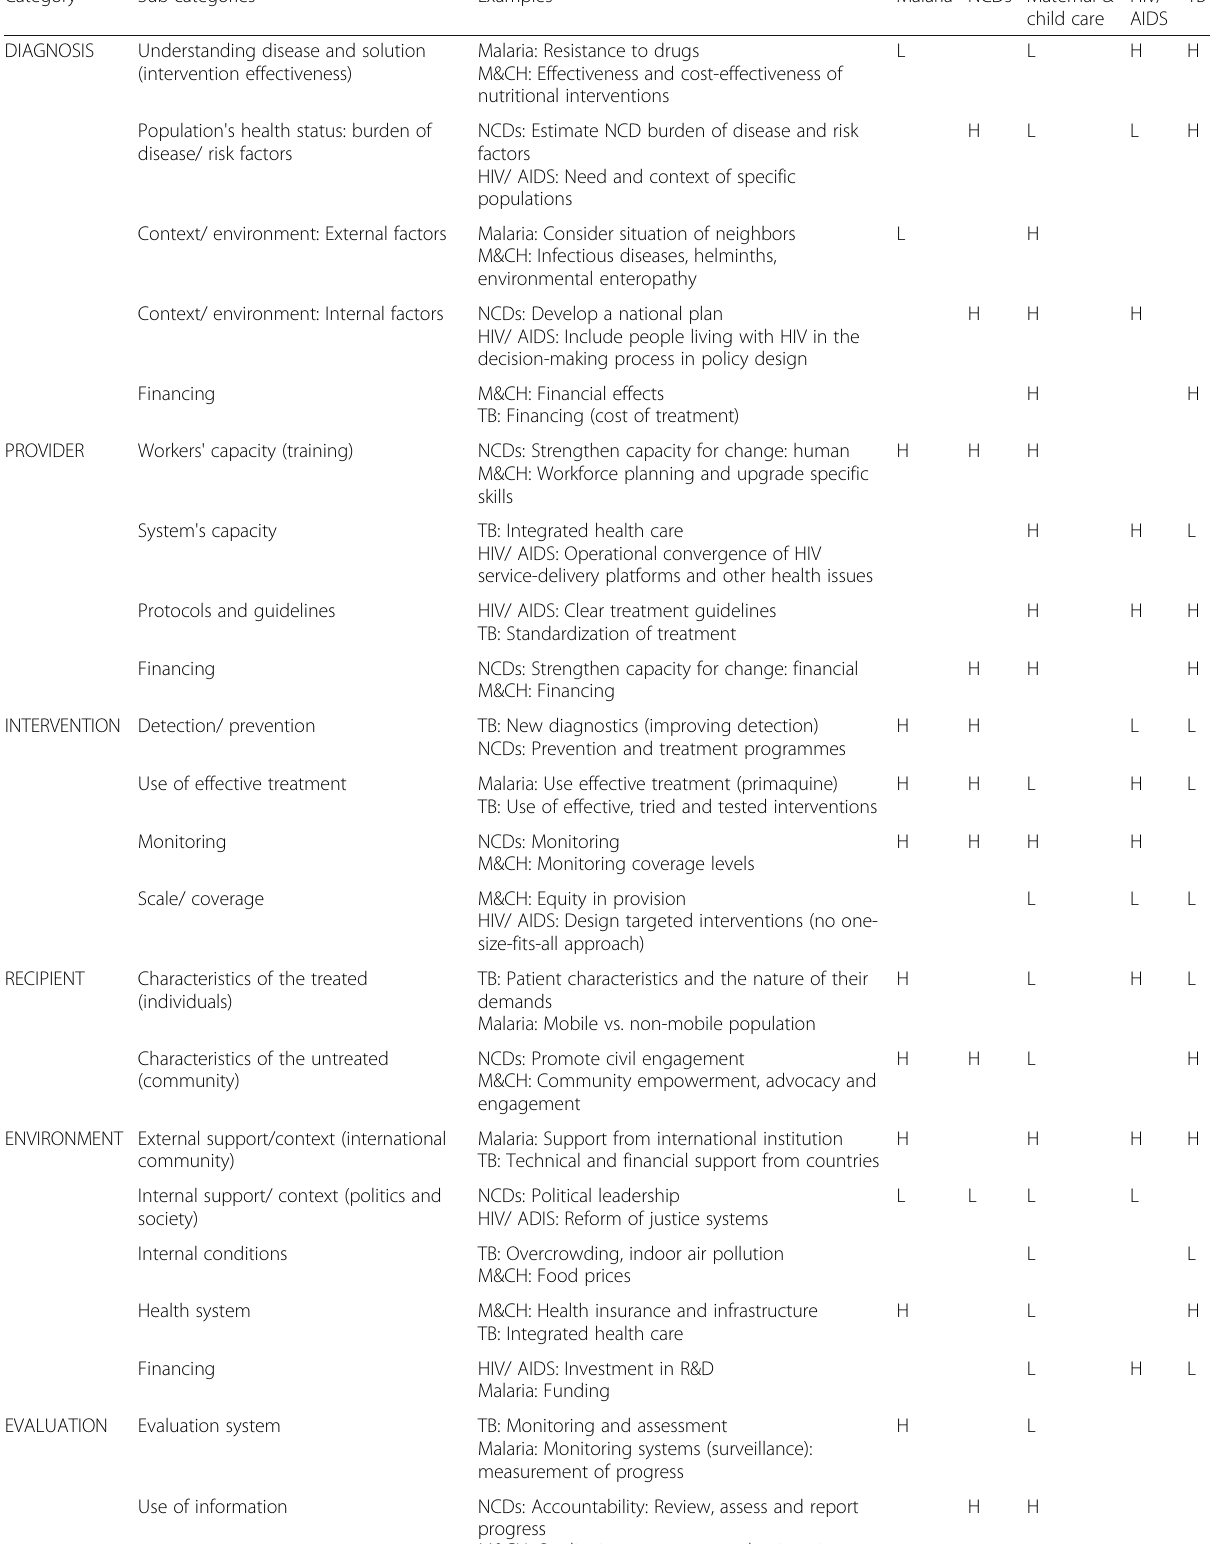
Table 3 Categories, sub-categories and examples from the Lancet series